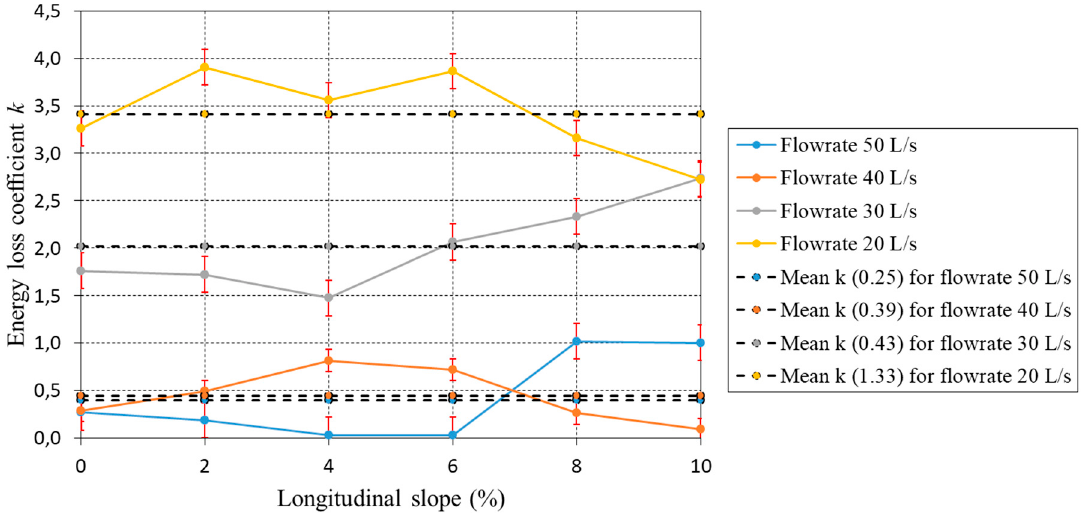
Figure 6. Graph of energy loss coefficient k of grate Barcelona1.